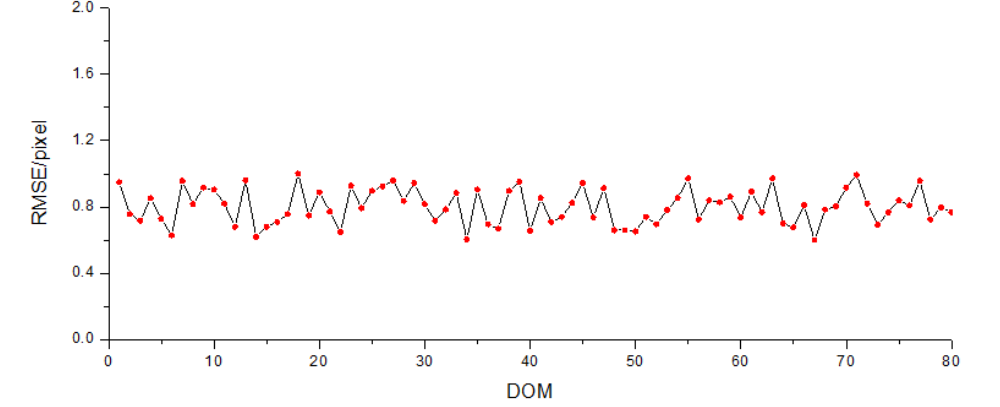
Fig. 5 Mosaic accuracy between adjacent DOMs